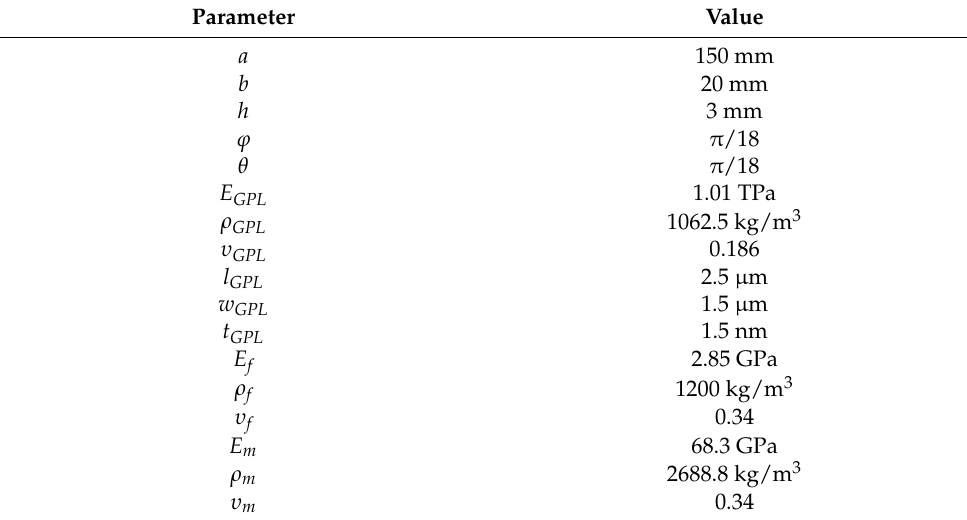
Table 7. Values of structural and material parameters. Table 7 . Values of structural and material parameters .